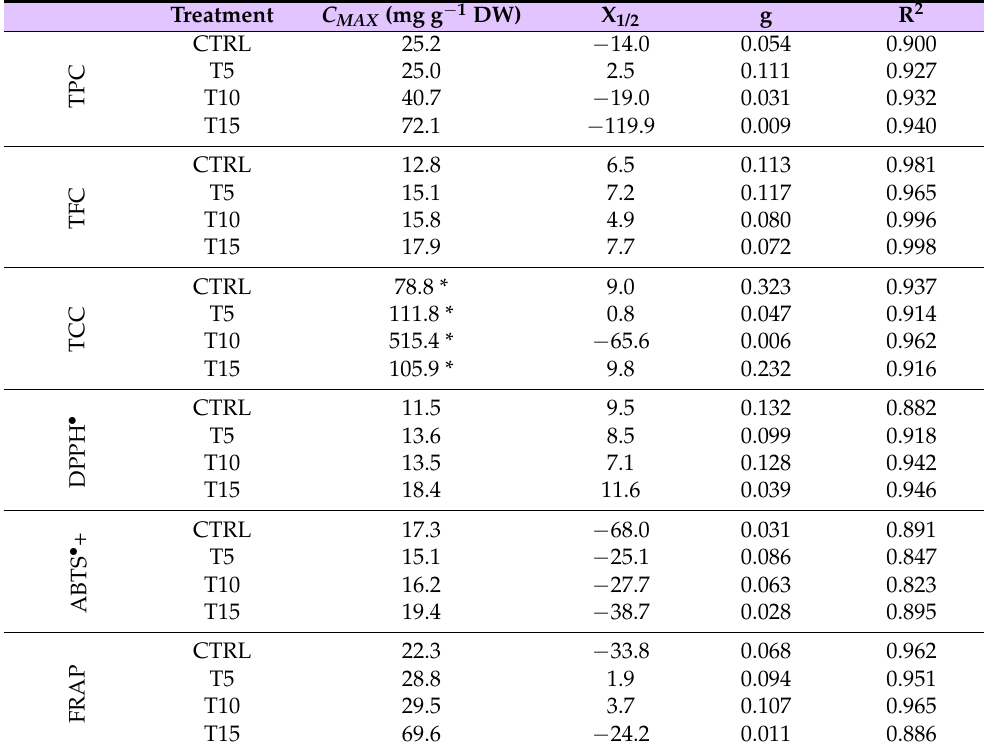
Table 2. Mathematical description models for the biosynthesis of the main bioactive compounds con- tent and for the total antioxidant capacity in UV-B-treated (0 (CTRL), 5, 10, and 15 kJ m − 2 ) red cabbage sprouts during 10 germination days at 20 ◦ C + 10 days at 4 ◦ C as a minimally processed product. Treatment C MAX (mg g − 1 DW) X 1/2 g R 2 C P T